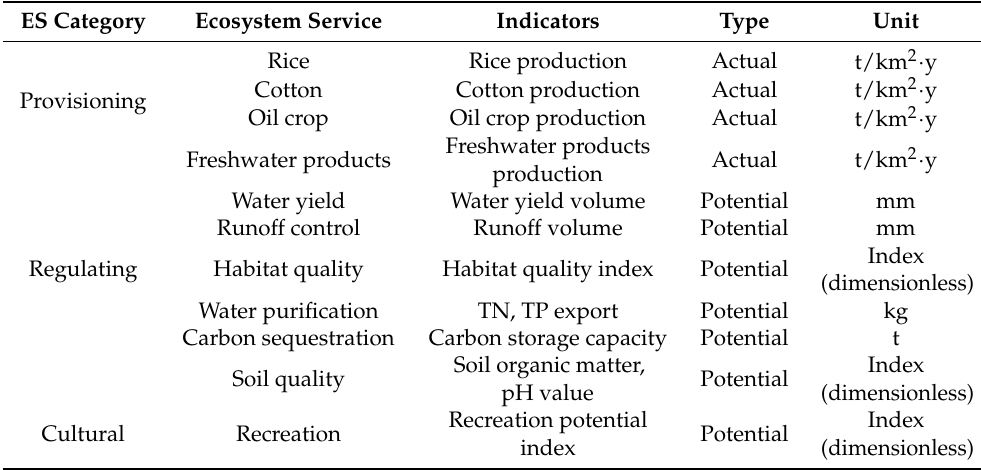
Table 1. Overview of ES assessment in Sihu agriculture